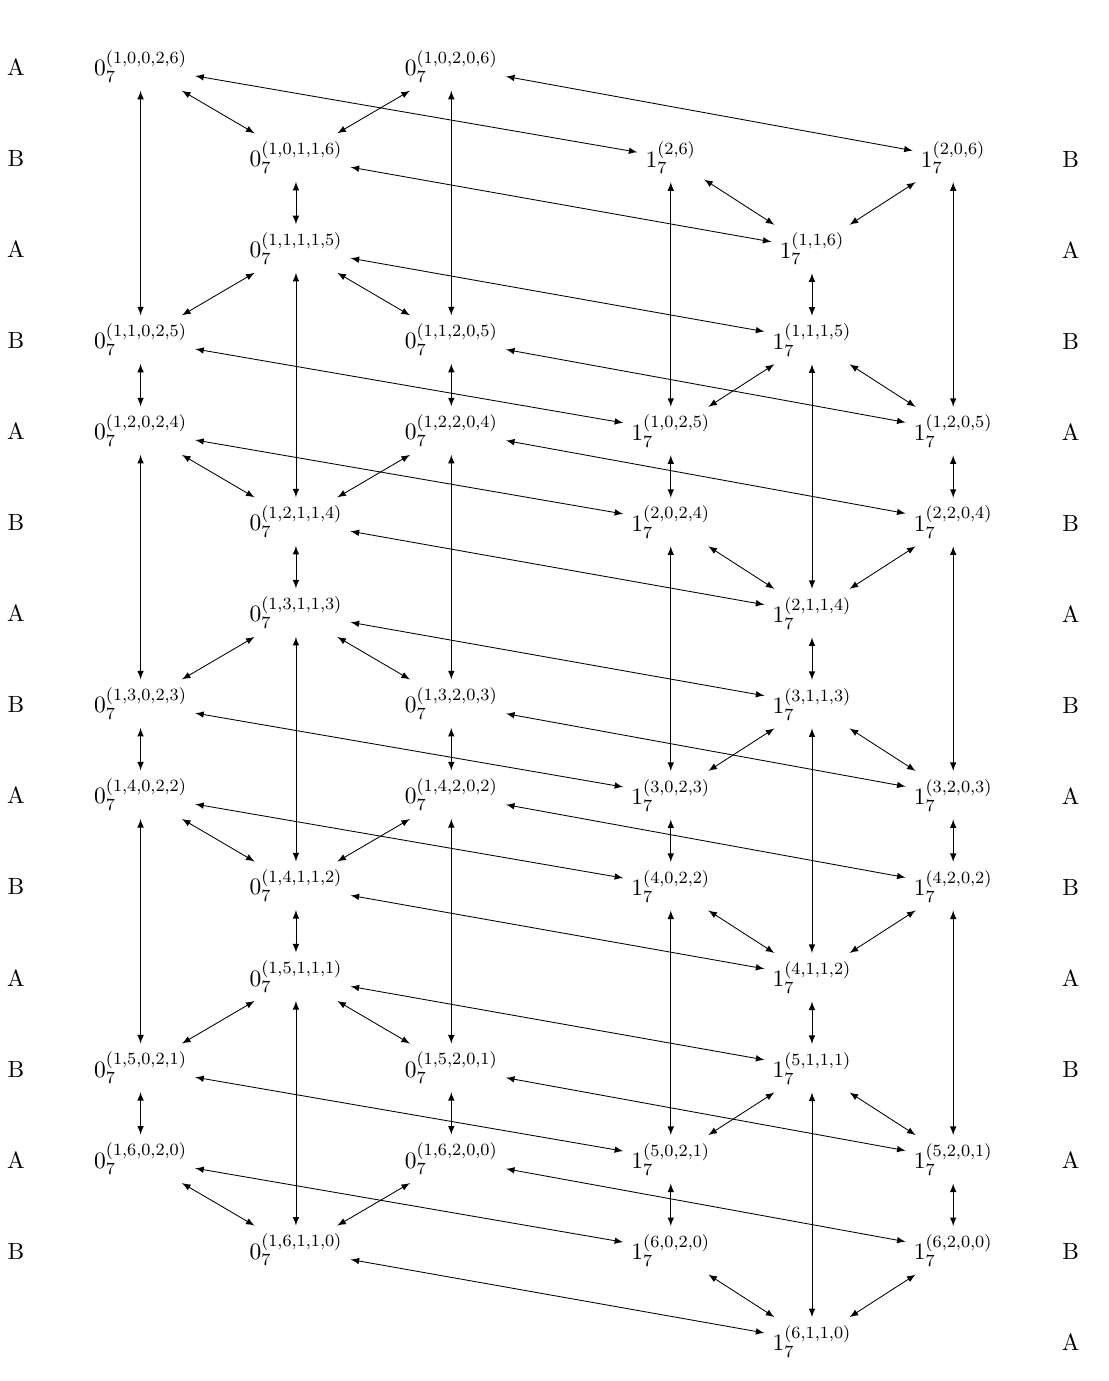
Figure 14 . The T-duality orbit of the 1 (2 ; 6)